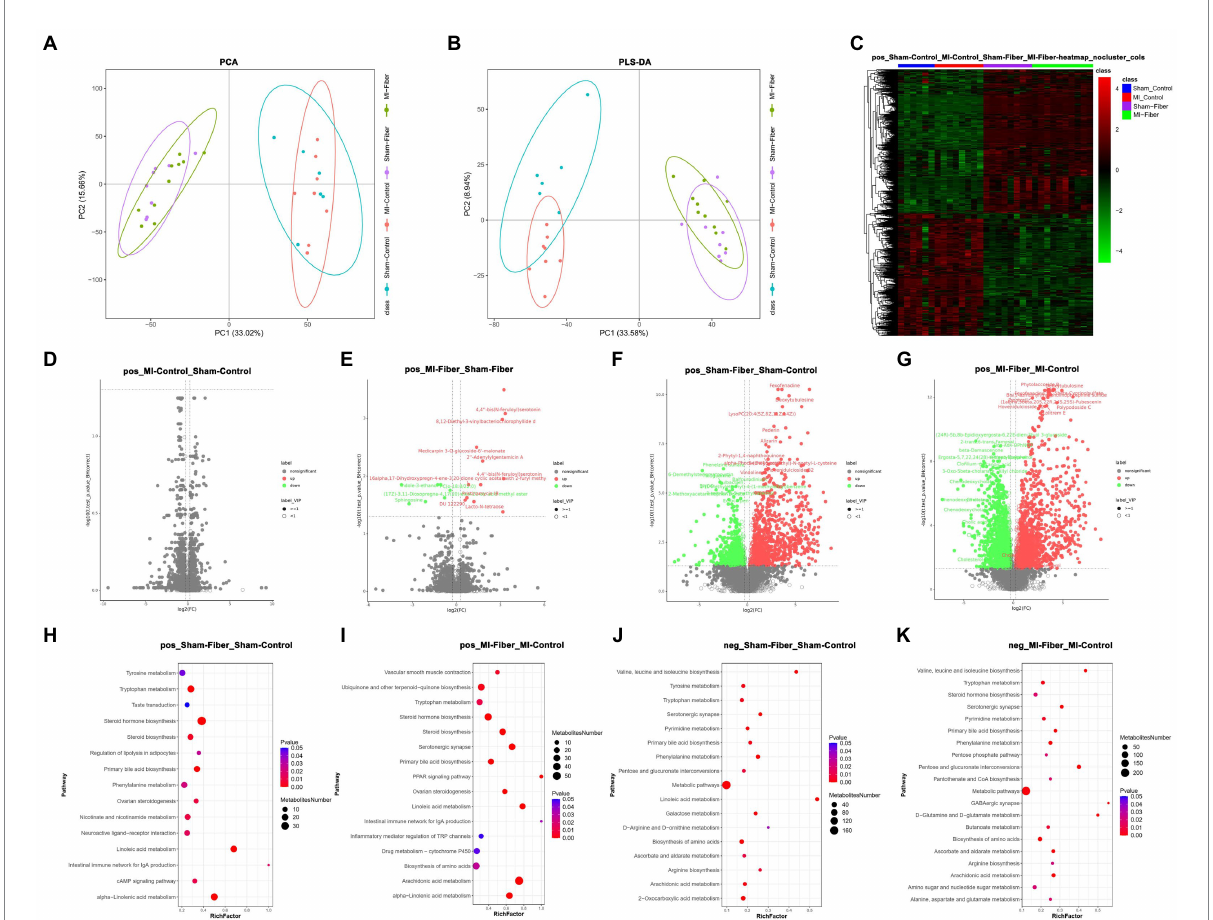
FIGURE 4 High fiber diet alters gut derived metabolites. (A , B) Principal component analysis analysis (A) and partial least squares discriminant analysis analysis (B) showed a distinctive metabolites composition among four groups. (C) Heat map depicting global metabolomic profiles among four groups. (D–G) Volcano plot disclosing the differences in metabolites between two groups in following ways: sham control vs. MI control (D) , sham fiber vs. MI fiber (E) , sham fiber vs. sham control (F) and MI control vs. MI fiber (G) . (H–K) Bubble chart distributing significantly different associated metabolic pathway between fiber diet groups and control diet groups in positive ions mode (H , I) and negative ions mode (J , K) . Sham control, n = 6; Sham fiber, n = 8; MI control, n = 8; MI fiber, n =